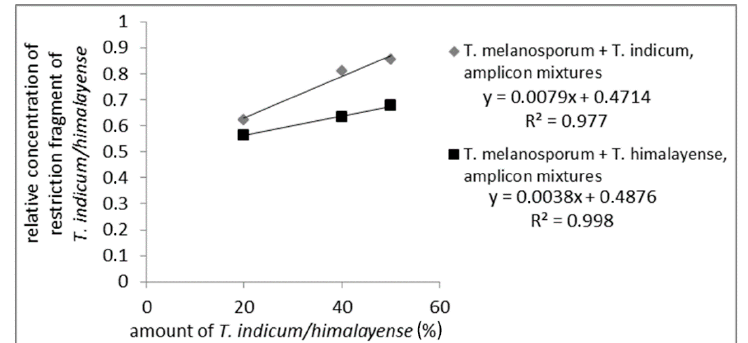
Figure 3. Standard curve of PCR-amplicon mixtures digested with Cvi QI from T. melanosporum with Asian black truffles added to 50%, 40%, and 20%. The concentration of the long restriction fragment of Asian truffles (500 bp) relative to the total concentration of restriction fragments is plotted against Asian truffle amount.